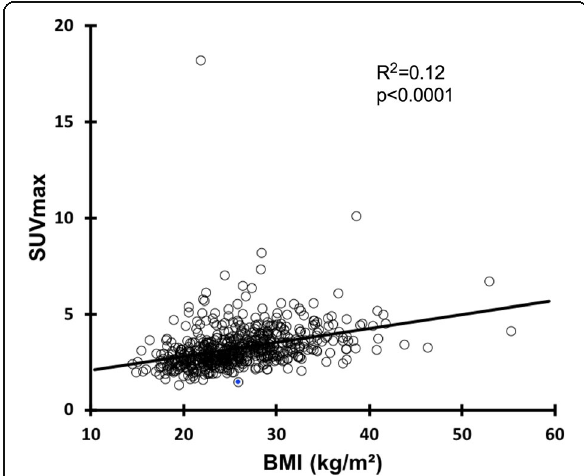
Fig. 3 Linear regression of SUV max_EARL and body mass index (kg/m 2